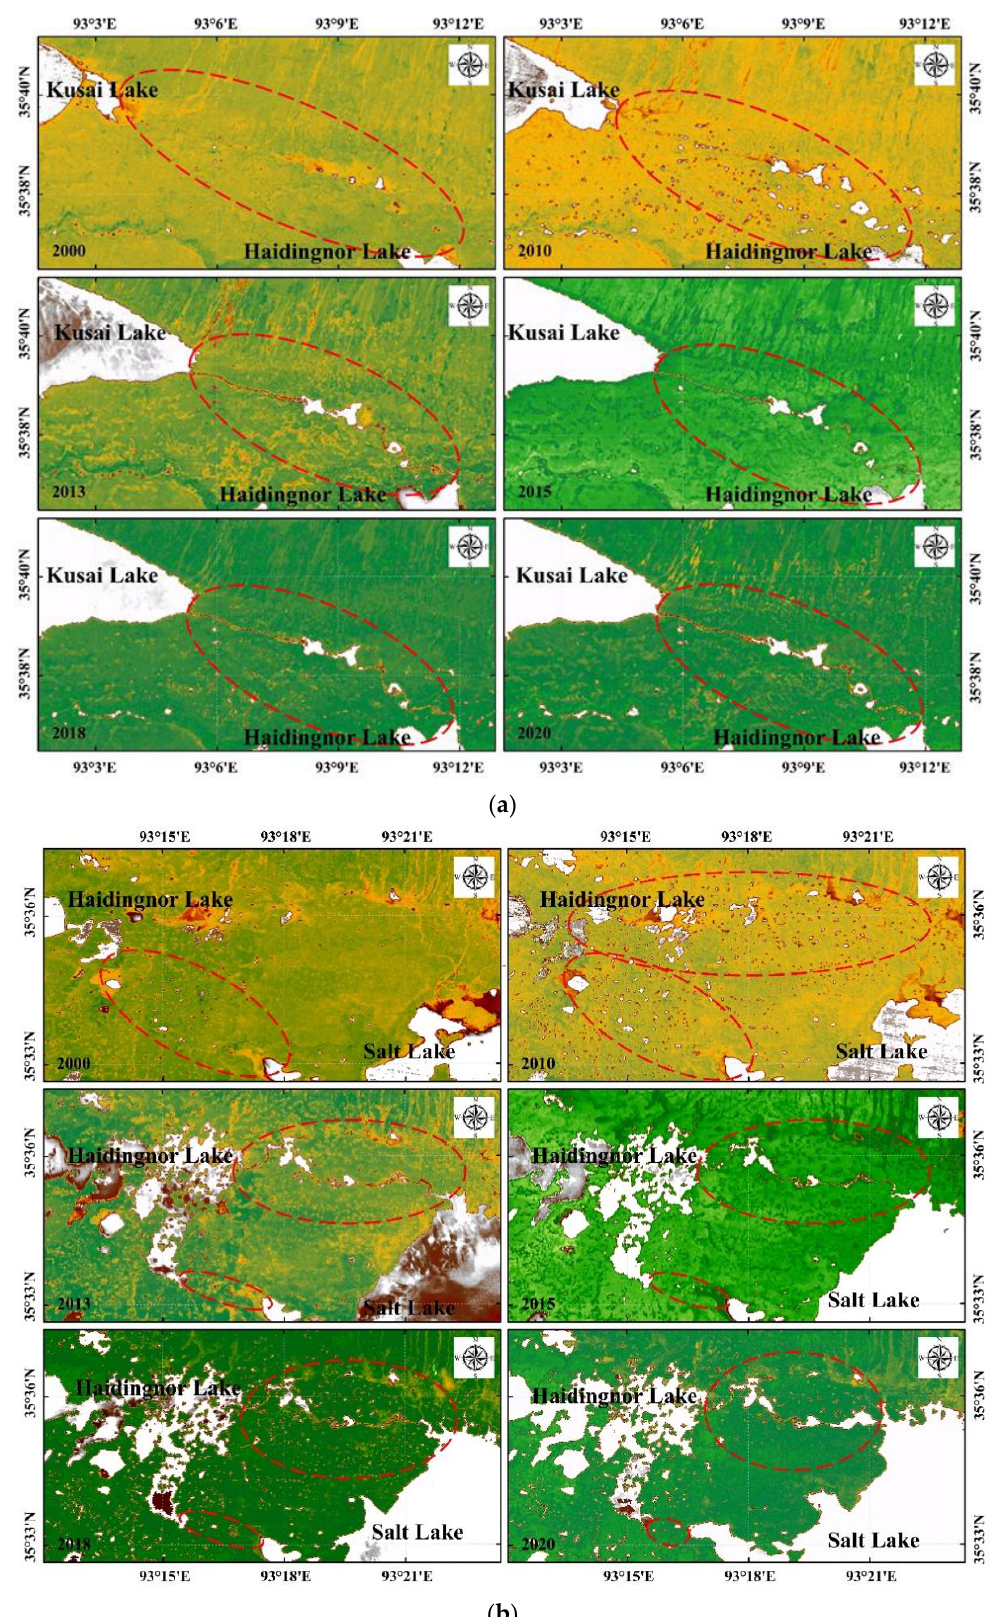
Figure 9. The EWI results of hydraulic connection between 2000 and 2020: ( a ) region between Kusai Lake and Haidingnor Lake; ( b ) region between Haidingnor and Salt Lake.